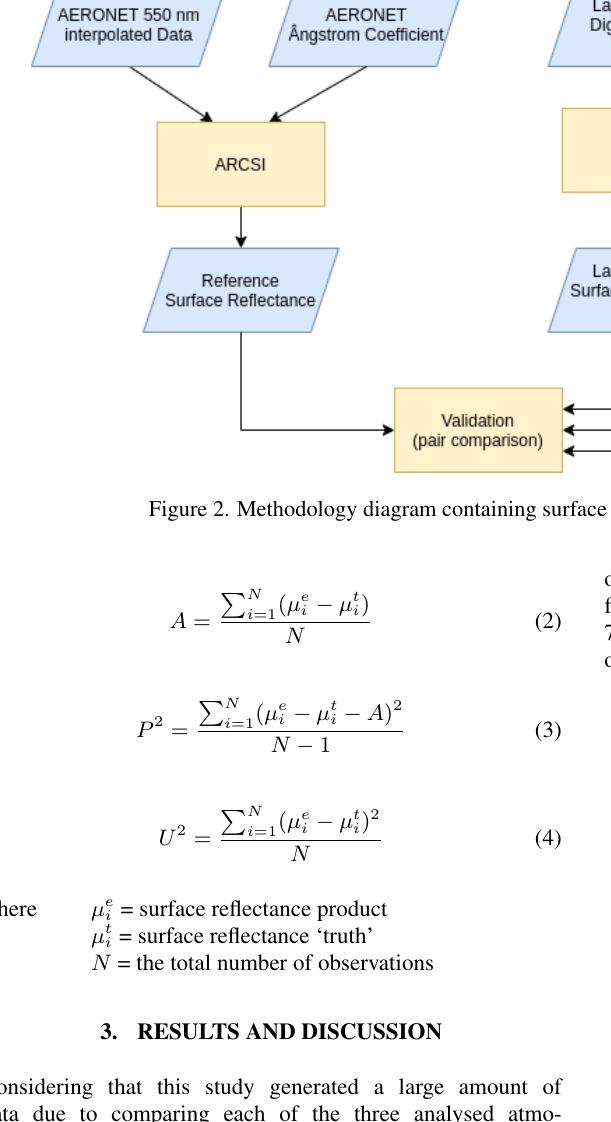
Figure 3. Scatter plot of Landsat-8/OLI Band 2 (Blue) image containing accuracy (red line), precision (green line), and uncertainty (blue line) as computed in bins (blue bars) where the magenta line represents the theoretical SR reference for Landsat SR (0 . 005 + 0 . 05 ˙ ρ )